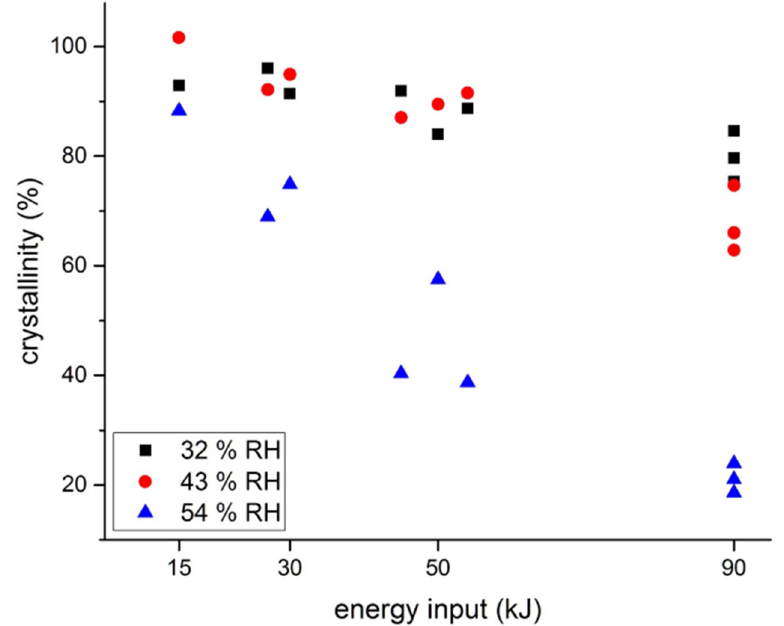
Figure 1. Crystallinity of IND (%, w/w ) versus energy input during microwaving of compacts that had been stored at 32%, 43% or 54% RH and microwaved at nine different settings. (Reproduced from [22]).